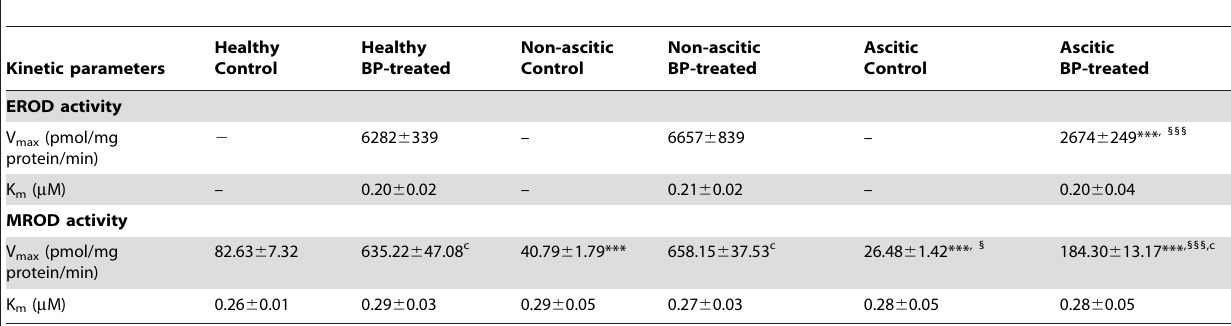
Table 2. Kinetic parameters for EROD and MROD activities of microsomal preparations obtained from control and BP-treated rats healthy and cirrhotic